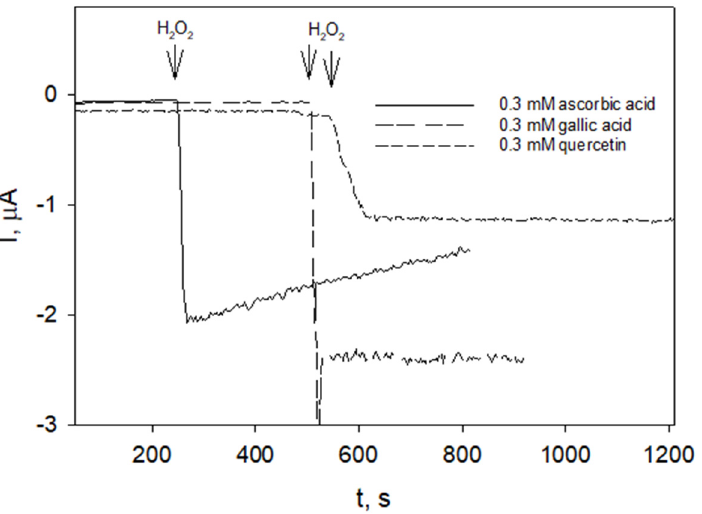
Figure 6. Responses of the GC/PB to the additions of H 2 O 2 into solutions of ascorbic acid, gallic acid, and quercetin (as indicated) in phosphate buffer pH 6.0, operating potential 0.0 V.